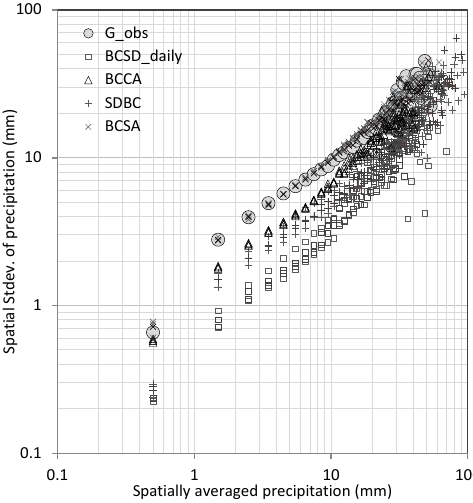
Fig. 16. Comparison of the relationship between spatial standard deviations (stdev.) of daily precipitation and the spatially aver- aged daily precipitation for observation and statistically downscaled GCM results. 4 GCMs are not separately represented but are indi- cated by the same marker for each downscaling